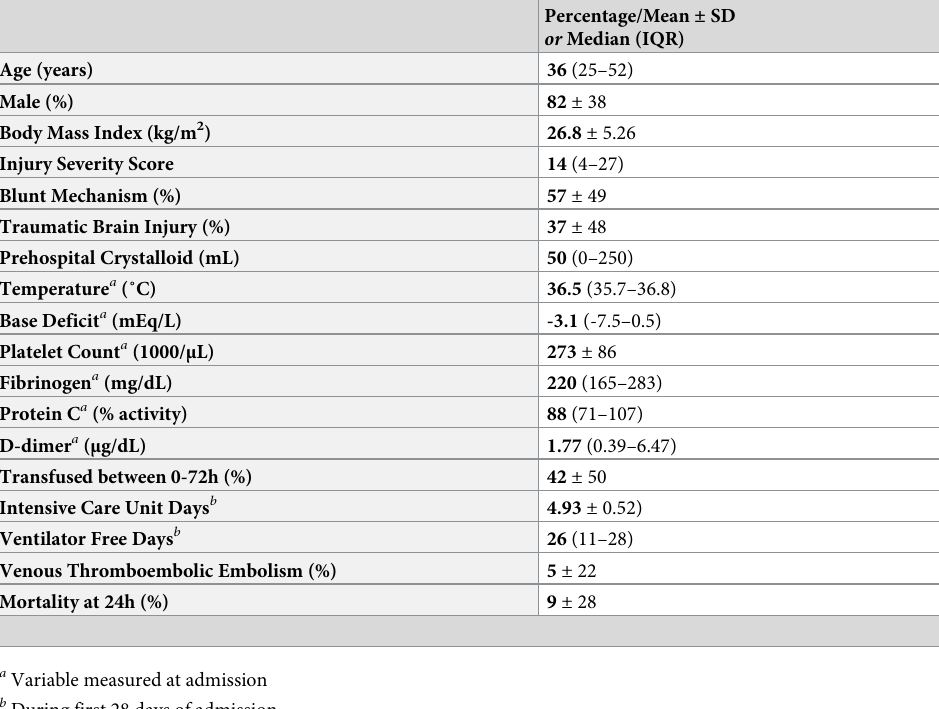
Table 2. Demographics, selected clinical variables and outcomes of the activation of coagulation and inflamma- tion in trauma